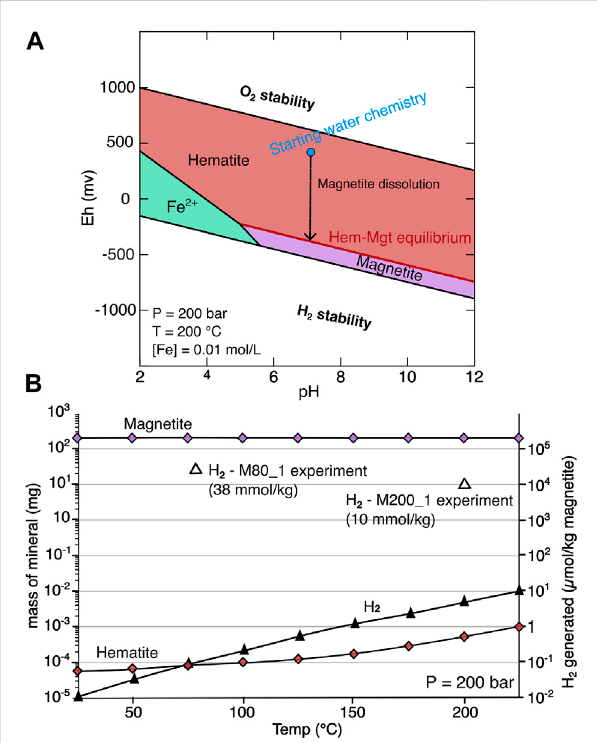
FIGURE 5 (A) Stability of Fe-oxides at 200 ° C/200bar, seen in an Eh-Ph diagram. Starting conditions for the modeling is plotted in blue and falls in the hematite domain. Hem refers to hematite, Mgt refers to magnetite. (B) Thermodynamic equilibrium after magnetite alteration for a water-rock ratio of 2, between 25 ° C and 225 ° C. Please note that the Y-axes for mineral mass and H 2 generated are in log-